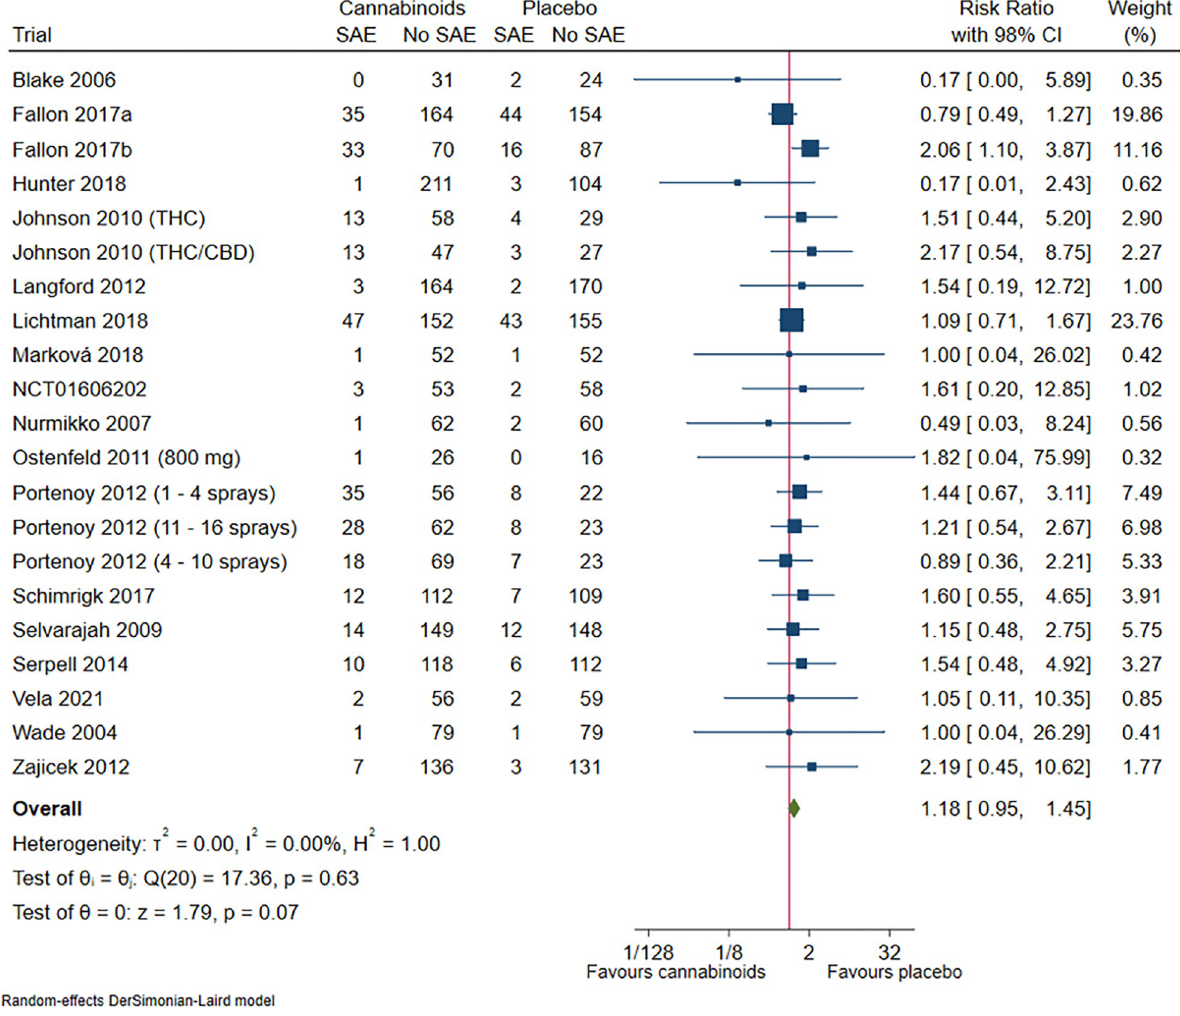
Fig 3. Forest plot of the meta-analysis of serious adverse events with 98% CI. assessing different types of pain, i.e. acute pain, cancer pain and chronic pain (P = 0.96) ( S32